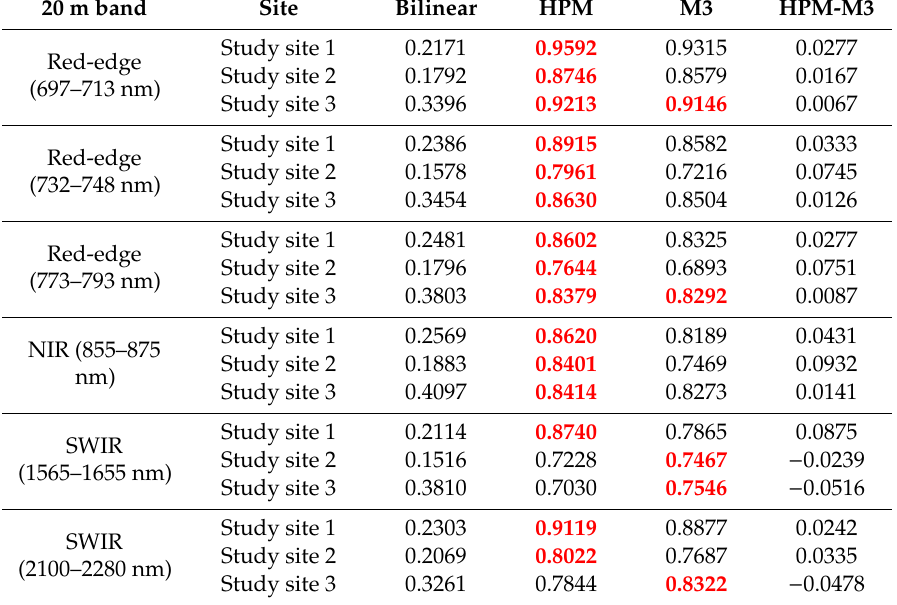
Table 10. Spatial subsets Q 2 n values derived considering the six Sentinel-2 20 m sharpened bands independently ( n = 1). The highest Q 2 n value (least distortion) for each study site is shown in red bold font, and if values are within two decimal places (i.e., | HPM-M3 | < 0.01), then both are shown in red